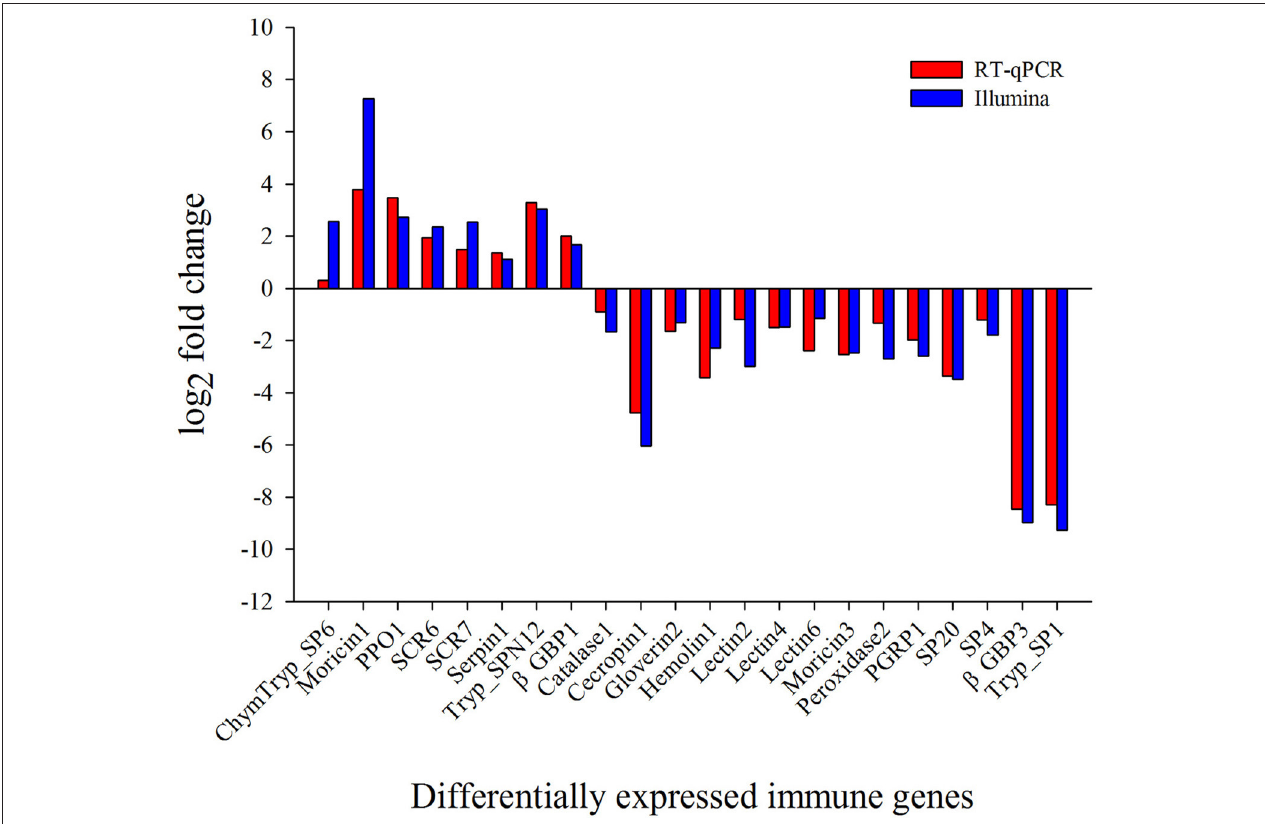
FIGURE 5 | Validation of differential expression ratio (log2) achieved by RT-qPCR and RNA-Seq for immunity-related genes. ChymTryp_SP6, Chymotrypsin like serine protease (Px_105397690); Moricin1, Moricin (Px_105392531); PPO1, prophenoloxidase (Px_105393828); SCR6, Scavenger Receptor (Px_105393261); SCR7, Scavenger Receptor (Px_105394486); Serpin1, Serpin (Px_105396587); Tryp_SPN12, Trypsin-like Serine Protease (Px_105393249); β GBP1, β -1,3-Glucan Binding Protein (Px_105380182); Catalase1, Catalase (Px_105398438); Cecropin1, Cecropin (Px_105394859); Gloverin2, Gloverin (Px_105389803); Hemolin1, Hemolin (Px_105394779); Lectin2, Lectin (Px_105395555); Lectin4, Lectin (Px_105392416); Lectin6, Lectin (Px_105392913); Moricin3, Moricin (Px_105392532); Peroxidase2, Peroxidase (Px_105388497); PGRP1, Peptidoglycan Recognition Protein (Px_105387866); SP20, Serine Protease (Px_105380853); SP4, Serine Protease (Px_105380869); β GBP3, β -1,3-Glucan Binding Protein (Px_105391537); Tryp_SP1, Trypsin-like Serine Protease (Px_105381636).